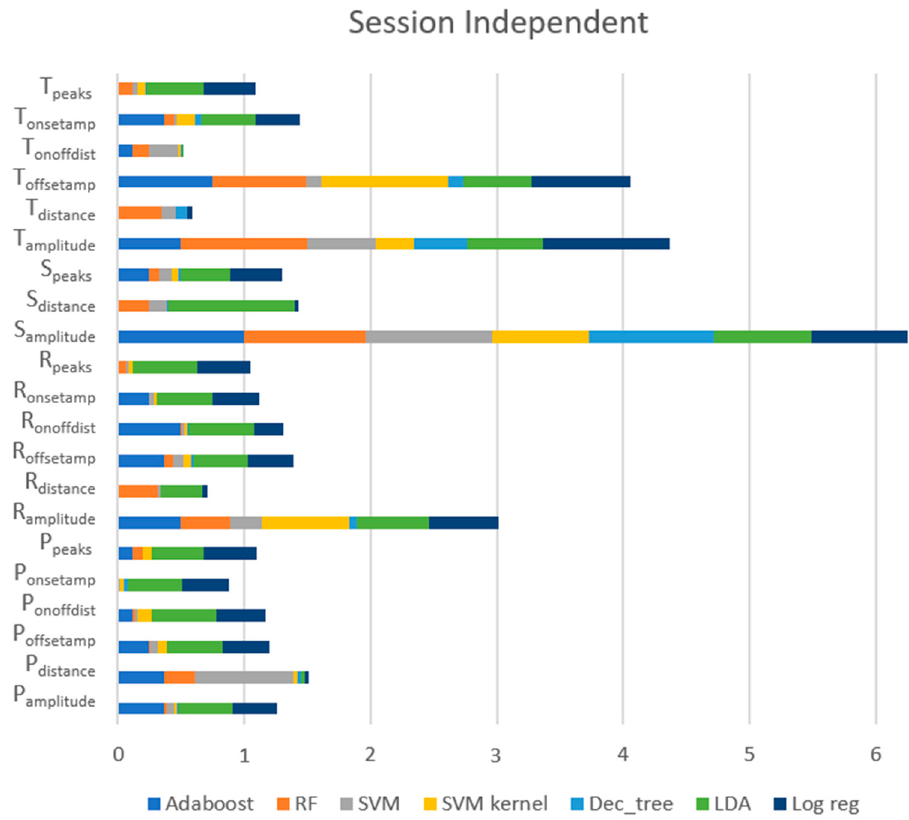
Figure 12. Importance of features for each model using the session-independent approach.